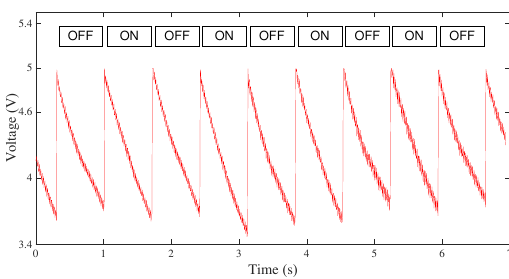
Figure 10. Red-to-blue link, T = 700